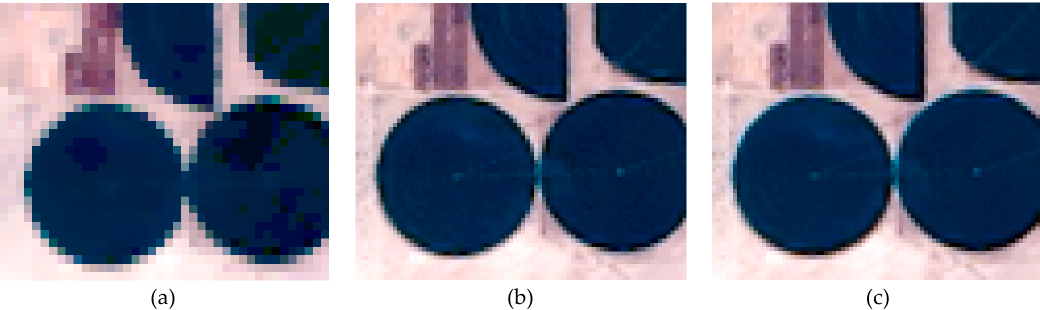
Figure 2. 40 × 33 Landsat-8 30-m image ( a ) LPAD downscaled to 15-m data (80 × 66) with ( b ) and without ( c ) considering the 15-m to 30-m Landsat-8 pixel grid shifts. The Landsat-8 image was acquired 6 November 2016 over a commercial crop field in California (centered on 34.8973°N 117.1505°W) with scene center solar zenith and azimuth of 36.5972° and 159.4612°, respectively.